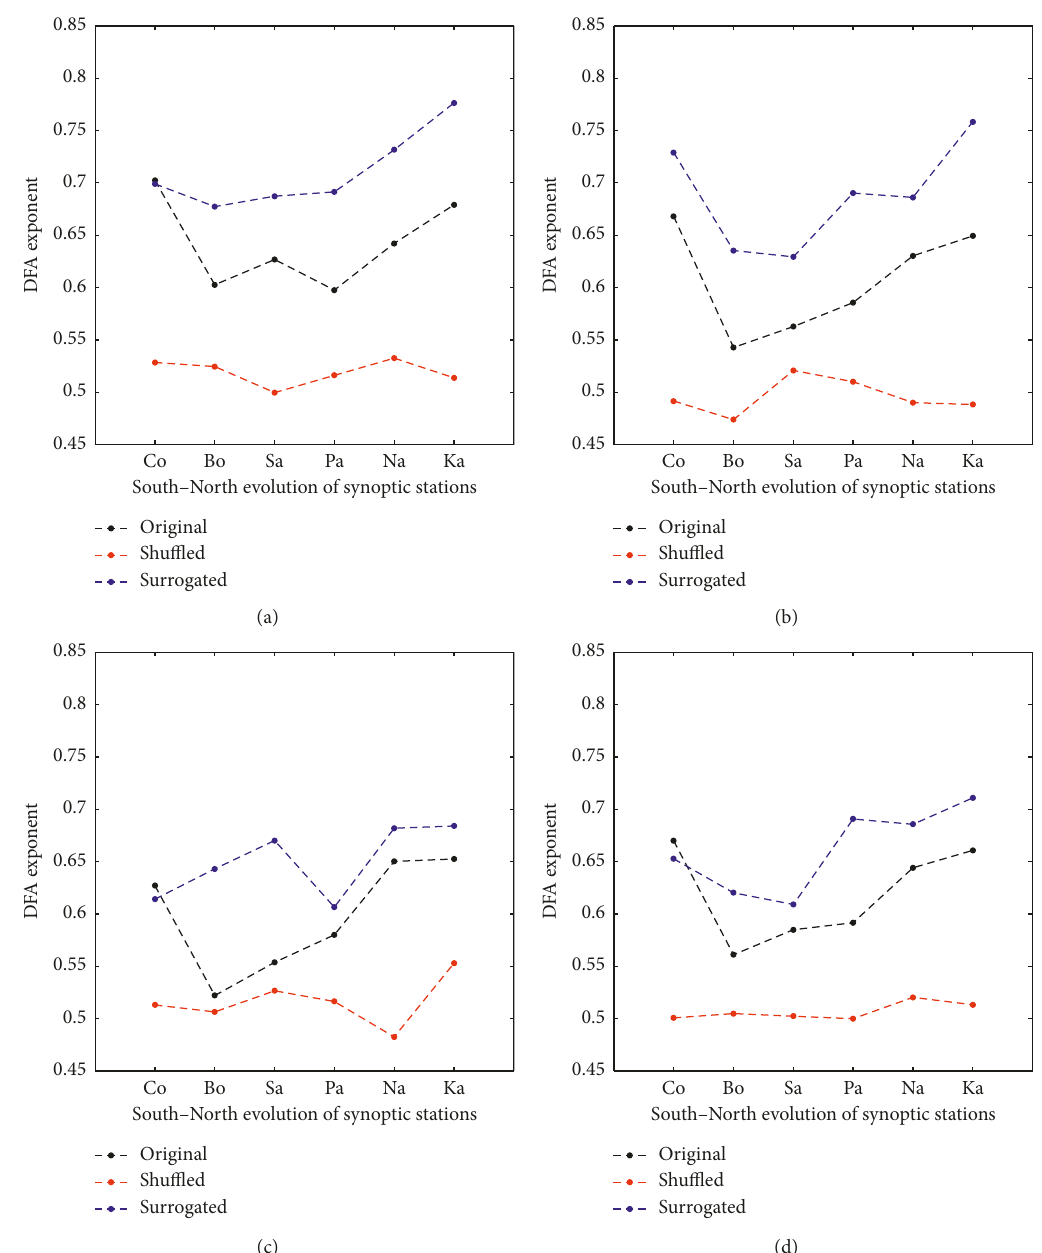
Figure 9: h orig (black line), h shuf (red line), and h surr (blue line) for original, shuffled, and surrogated data obtained over 1951–1970